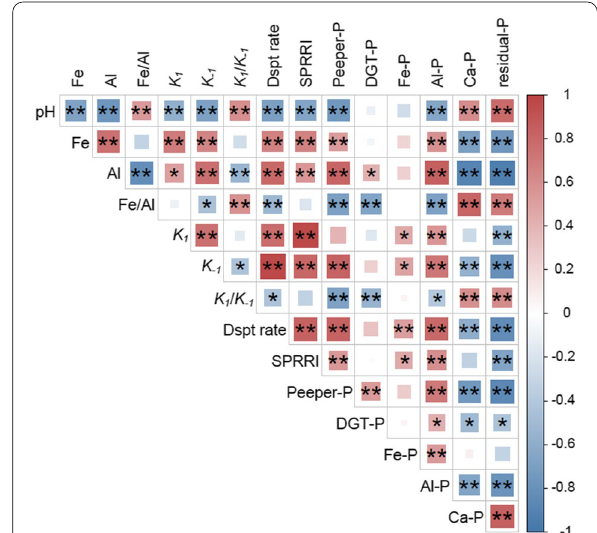
Fig. 5 Pearson correlation diagram between pH, Fe (BD-Fe), Al (NaOH25-Al), DIFS model output parameters ( K 1 , K -1 , K 1 / K -1 , and Dspt rate), SPRRI values, Peeper-P, DGT-P, and soil P fractions (Fe–P, Al–P, Ca–P, and residual-P) including field and greenhouse pot experiments. *Significant at p < 0.05, **Significant at p <